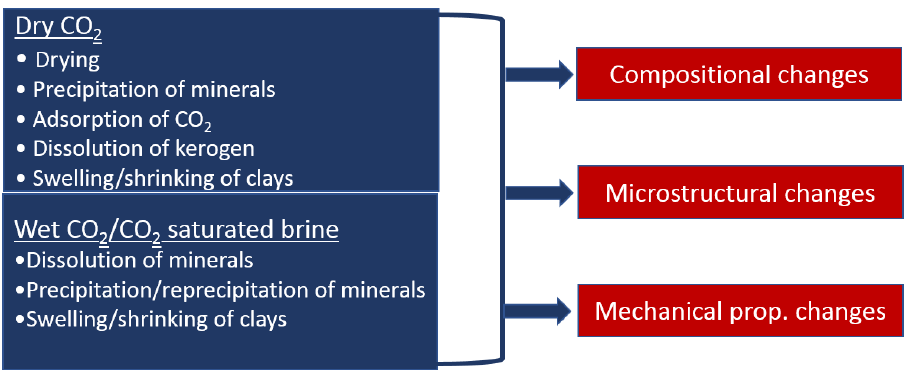
Figure 7. Processes occurring in shale rocks upon exposure to dry CO 2 , water-saturated CO 2 , and CO 2 - saturated brine.